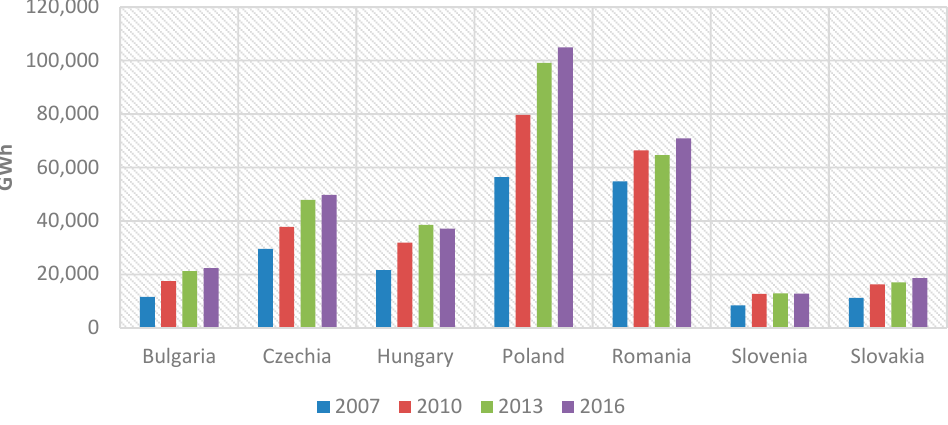
Figure 5. Renewable energy primary production, Source: Own representation based on EUROSTAT data [12].